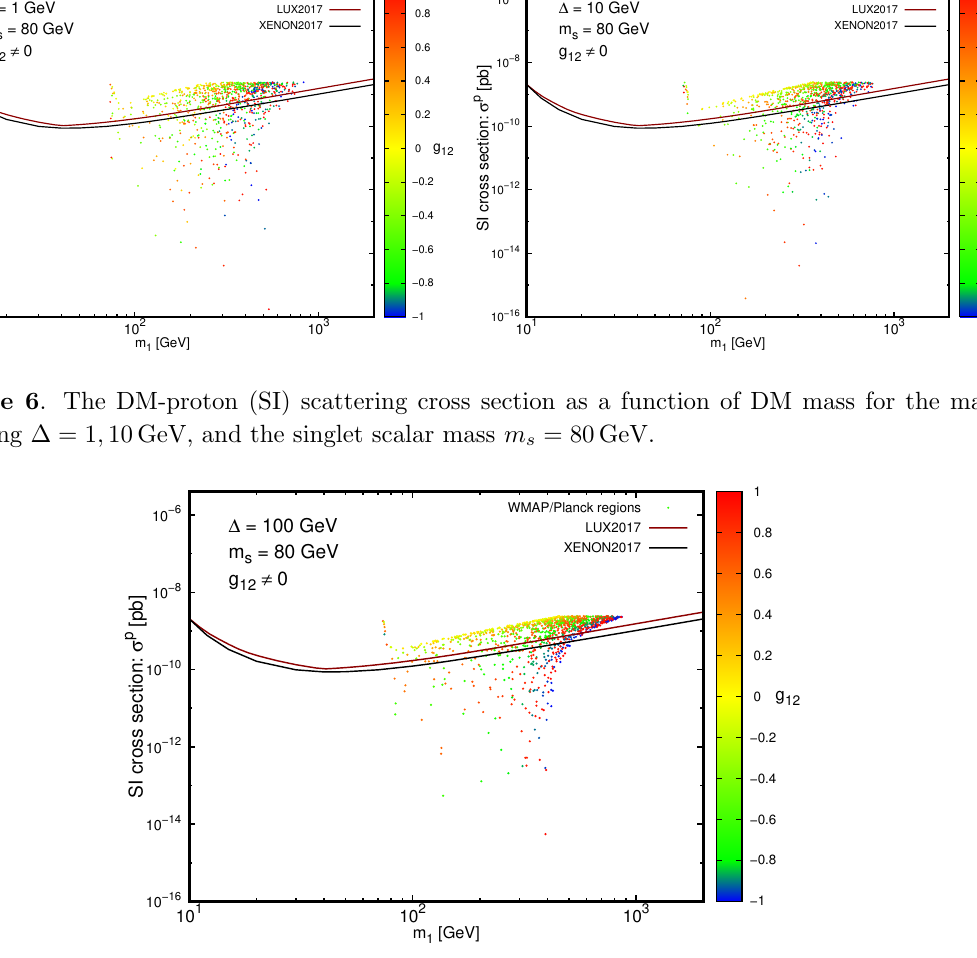
Figure 7 . The DM-proton (SI) scattering cross section as a function of DM mass for the mass splitting (cid:1) = 100 GeV, and the singlet scalar mass m s = 80